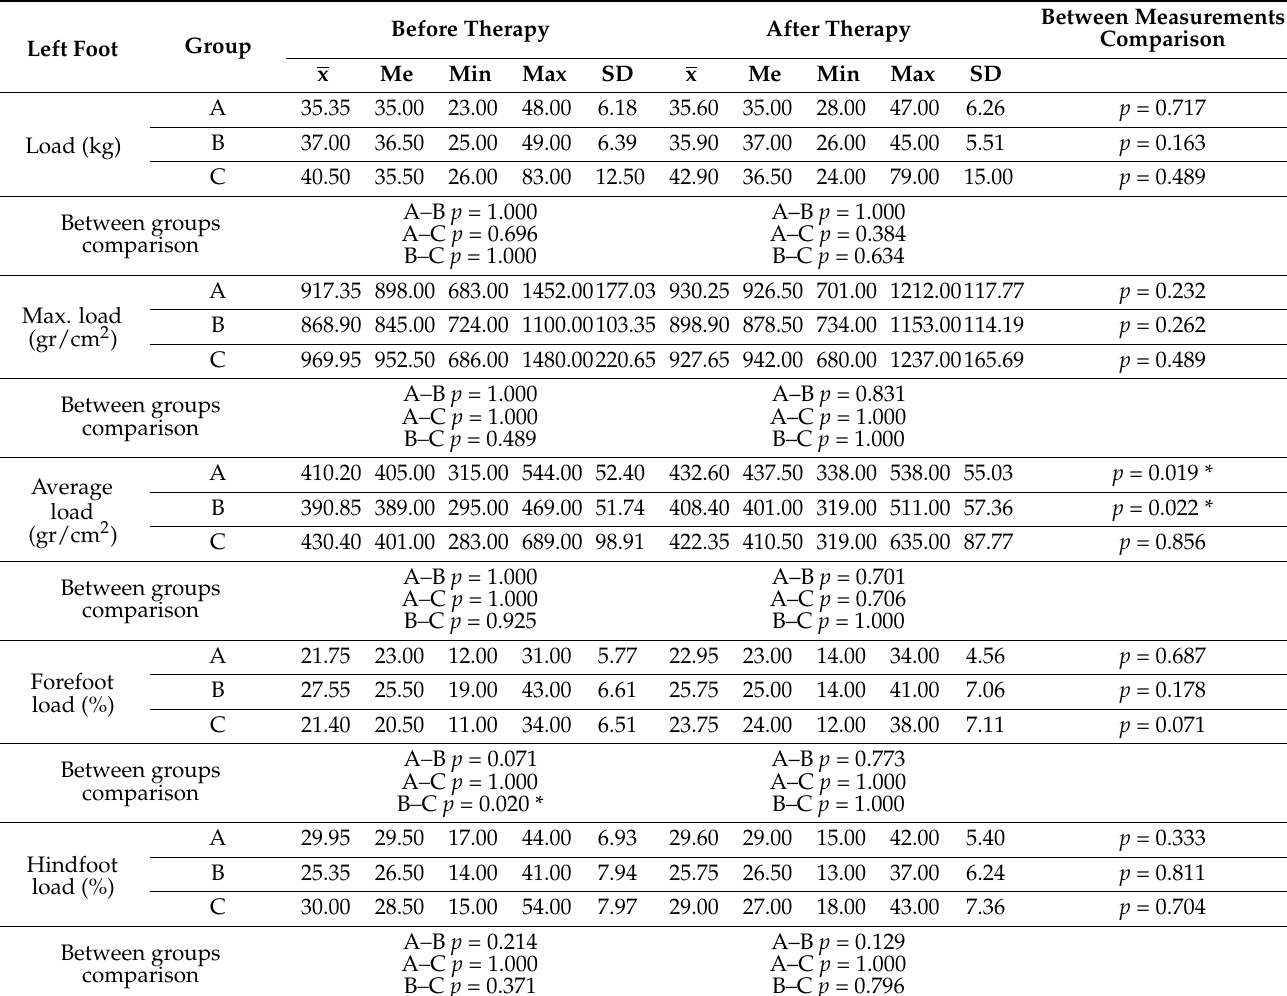
Table 2. Differences between selected left foot static indicators in the individual groups before and after